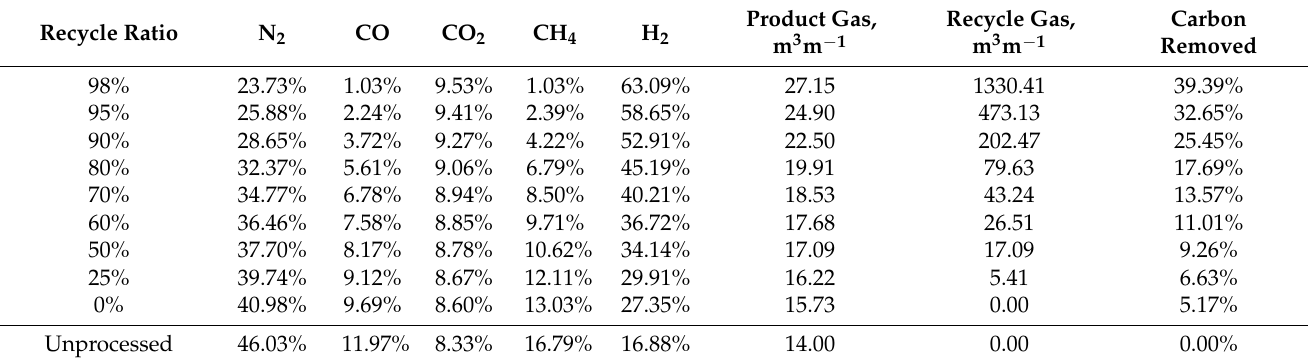
Table 4. Impact of recycle ratio on the stable average gas product output. Part of the gas product (recycle gas) is recycled from the ZVI Reactor to the ZVI Reactor (Figure 24). Recycle Period = 480 min. All gas flow rates are standardised to the feed gas supplied from a Maclaurin retort, processing 20 t coal d − 1 . The bulk of the removed carbon is retained in ZVI desalination pellets. Recycle ratio is the proportion of product gas which is recycled to the ZVI Reactor.